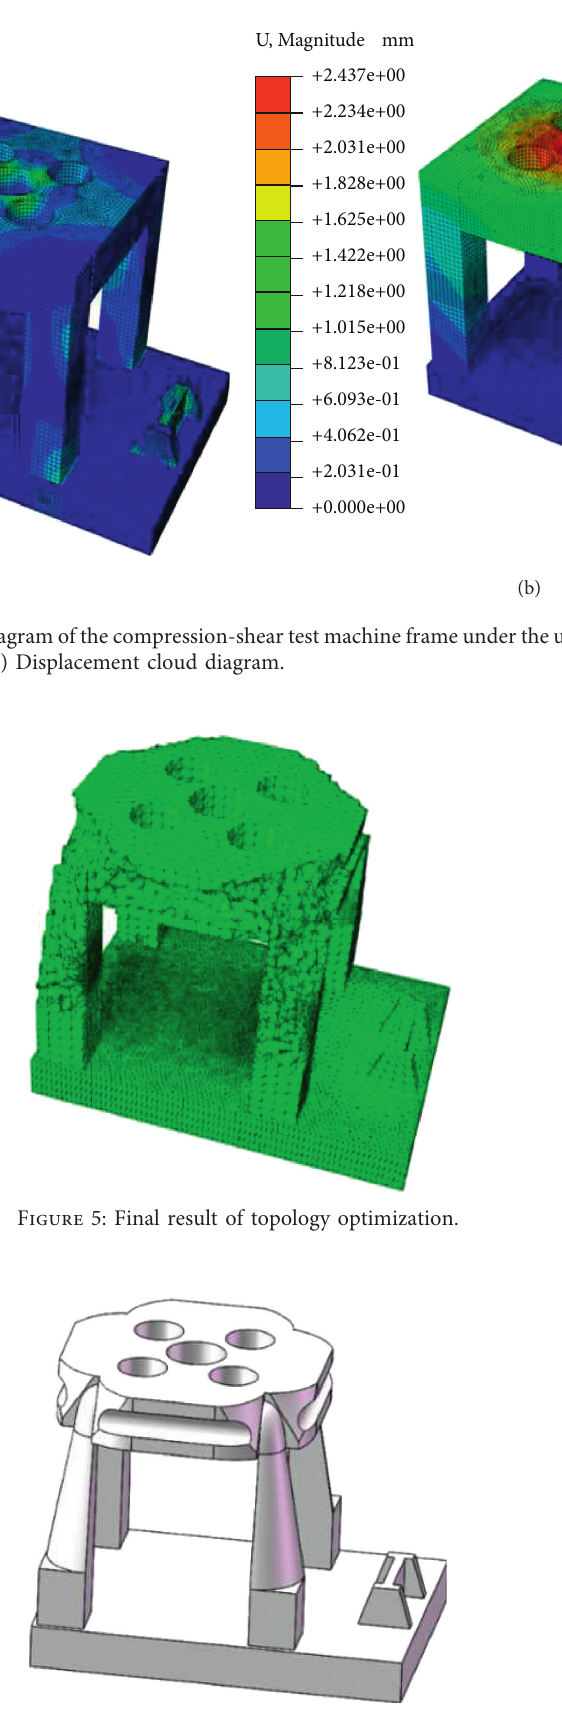
Figure 6: Optimized and reconstructed of compression-shear test machine